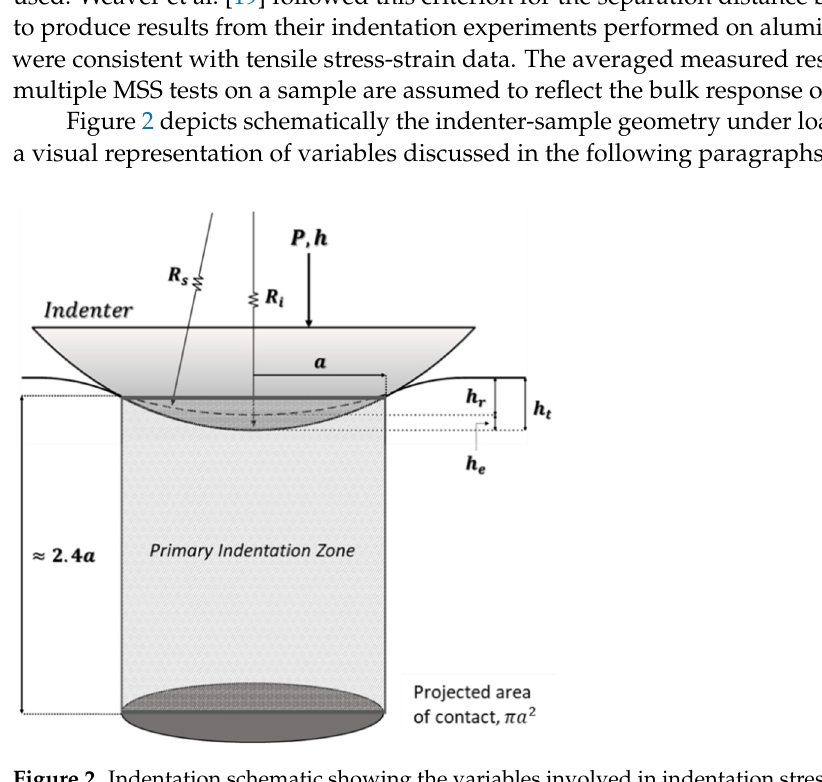
Figure 2. Indentation schematic showing the variables involved in indentation stress-strain protocols. The indentation stress definition is based on the load applied over the projected area of contact, π a 2 , where a is the contact radius. The indentation strain definition is based on the dimensions of the primary indentation zone, which describes a cylindrical domain of height 2.4 a , and radius a being compressed by the total indenter displacement, h t which is the sum of the sample elastic displacement, h e , and the residual displacement, h r